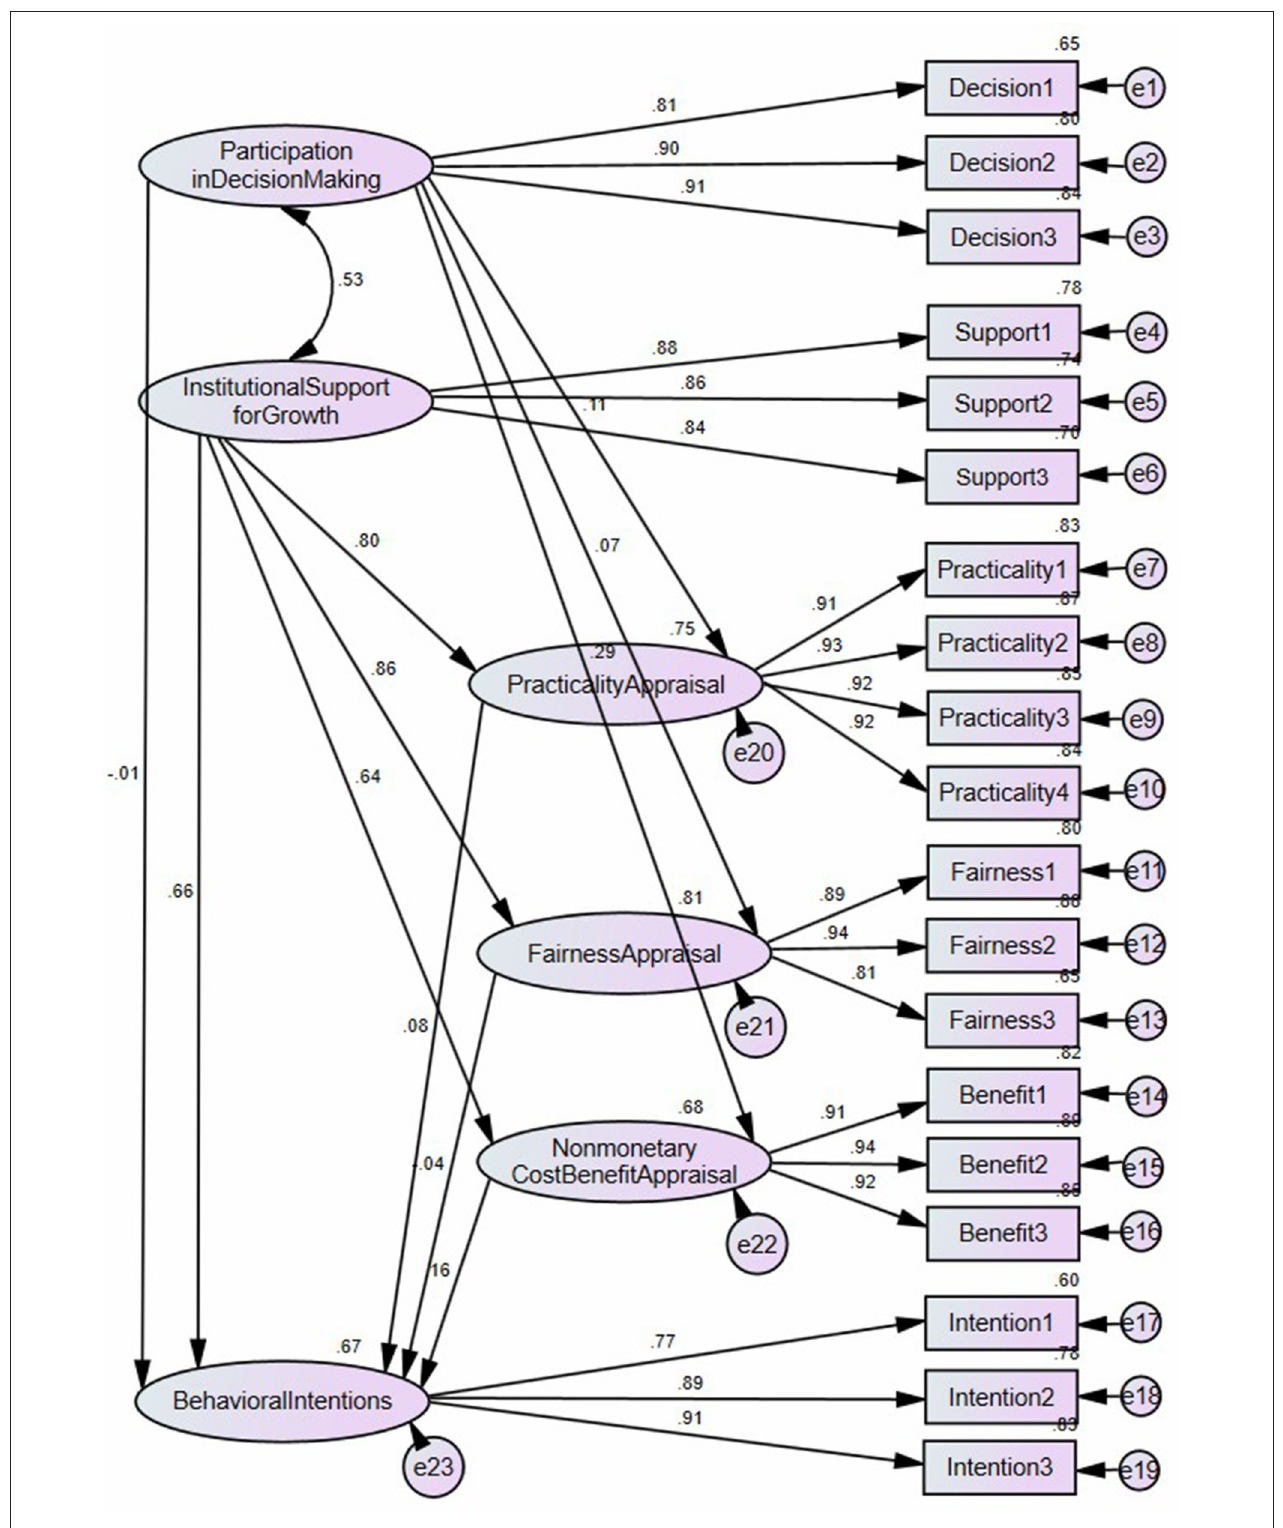
FIGURE 4 | Structural equation modeling ( N = 340). The 32 professors’ responses are taken out.